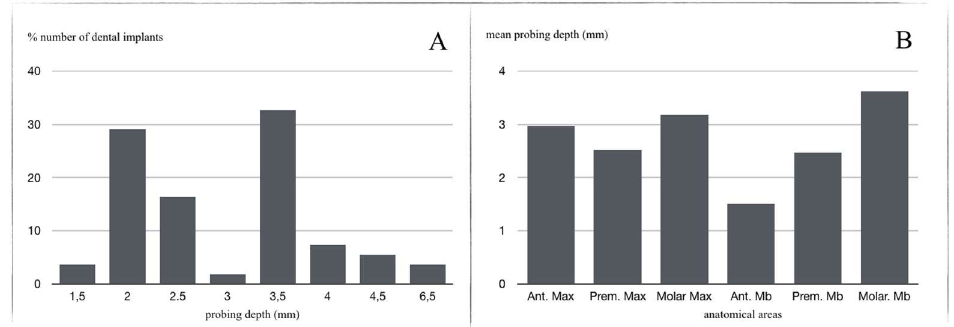
Figure 4. ( A ) Numbers of dental implants (%) according to PD (mm); ( B ) PD (mm) in relation to location (%); ( C ) PD (mm) in relation to location.